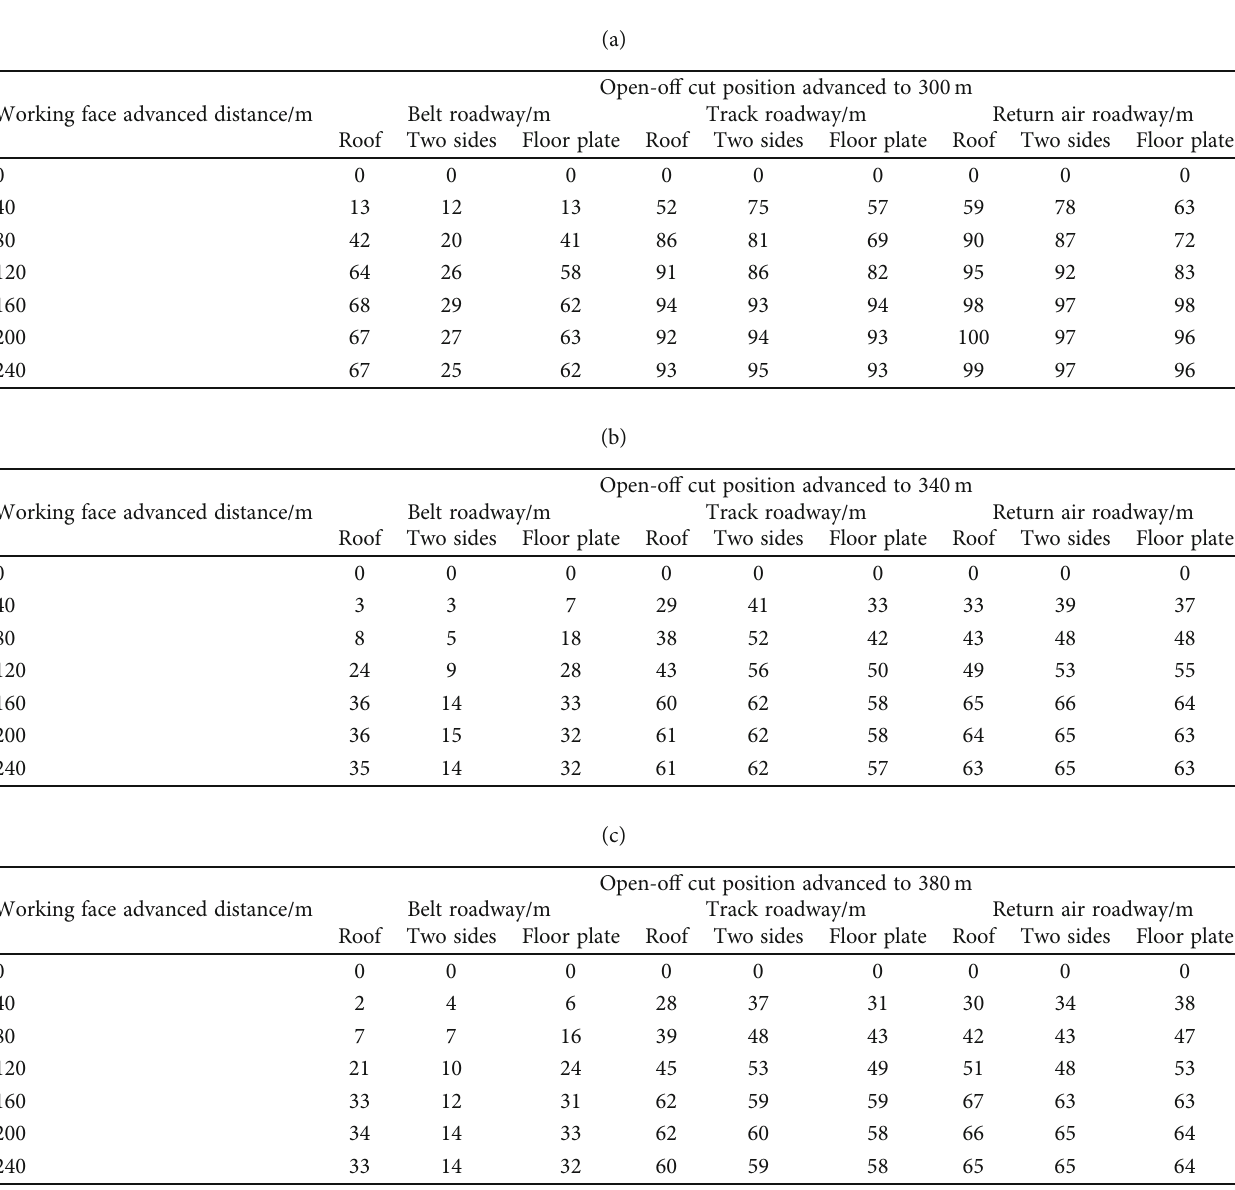
Table 2: Plastic zone width of roadway surrounding rock with di ff erent open-o ff cut